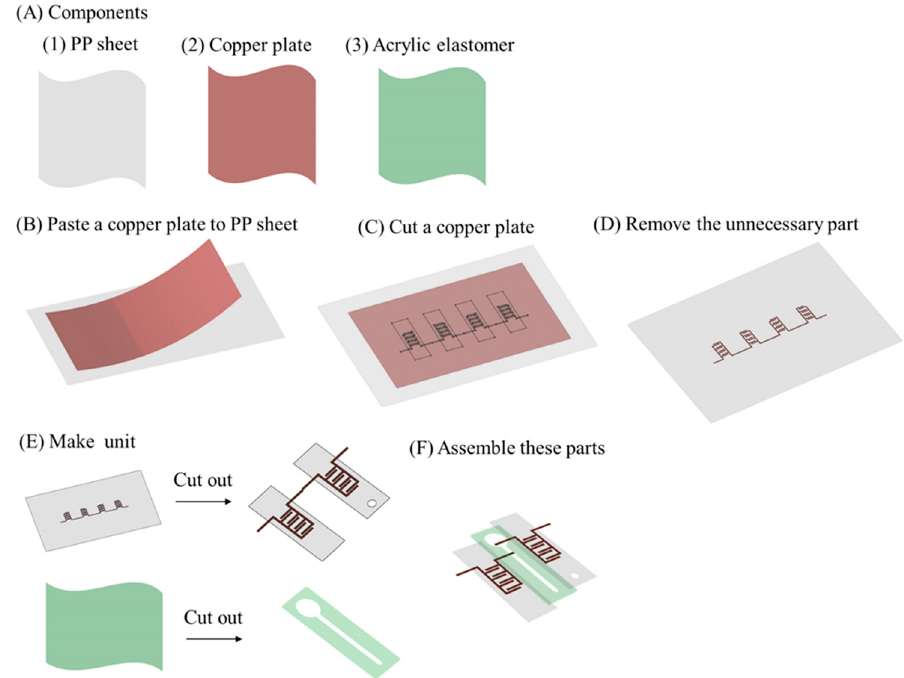
Figure 4. Fabrication methods for focus-tunable lens driven by EHD pump. ( A ) Main components used in the EHD lens. ( B ) A copper plate is pasted onto the PP sheet. ( C ) Cutting into the copper plate. ( D ) Removing the unnecessary part. ( E ) Making units. ( F ) Assemble to complete the EHD lens.